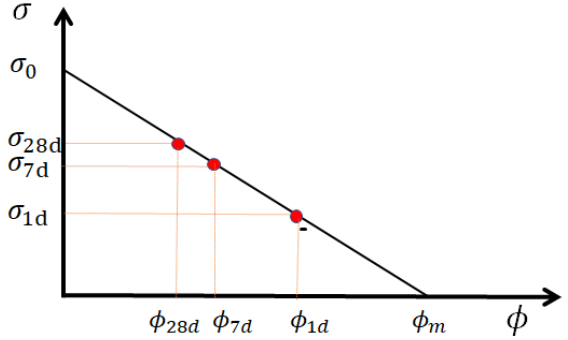
Figure 1. Schematic representation of compressive strength as a function of porosity. φ m is the critical (lowest) porosity at zero strength, whereas φ 1 d , φ 7 d , and φ 28 d are porosities at 1, 7 and 28 days, giving, respectively, the compressive strengths σ 1 d , σ 7 d , σ 28 d in a linear relation. The maximum compressive strength σ 0 is obtained when porosity reaches zero (if possible).